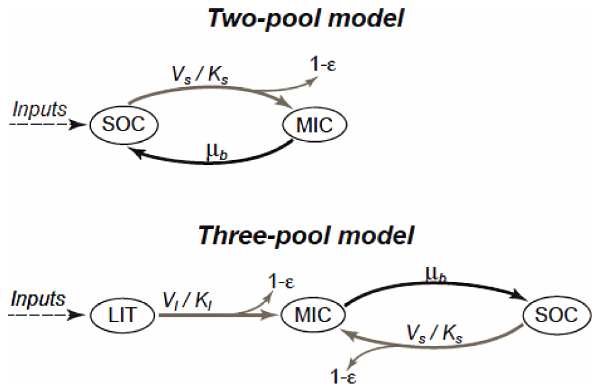
Fig. 1. Schematic diagrams showing the structure of two-pool and three-pool models. Carbon input enters the soil organic carbon (SOC) pool directly in the two-pool model, and litter carbon pool (LIT) in the three-pool model. When carbon from litter or soil or- ganic carbon is consumed by soil microbes, a fraction of the con- sumed carbon, 1 − ε , is lost as CO 2 , where ε is microbial growth efficiency. See main text for the definitions of all other